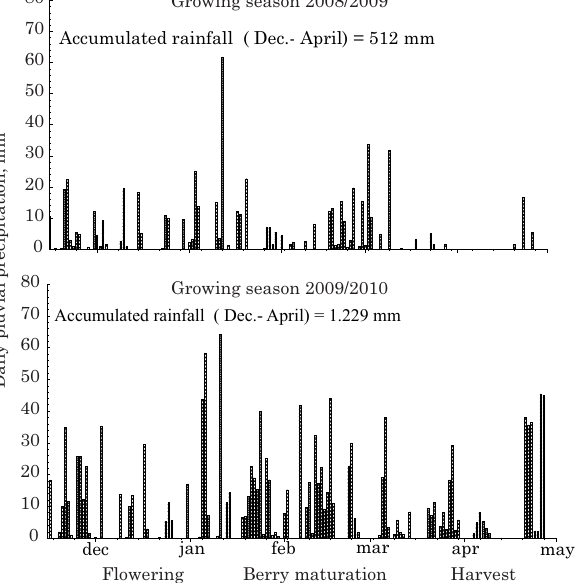
Figure 2. Daily pluvial precipitation at Epagri Experimental Station, 2.8 km away from the experimental area, in the growing season 2008/ 2009 and 2009/2010 (Epagri-Ciram, 2011).